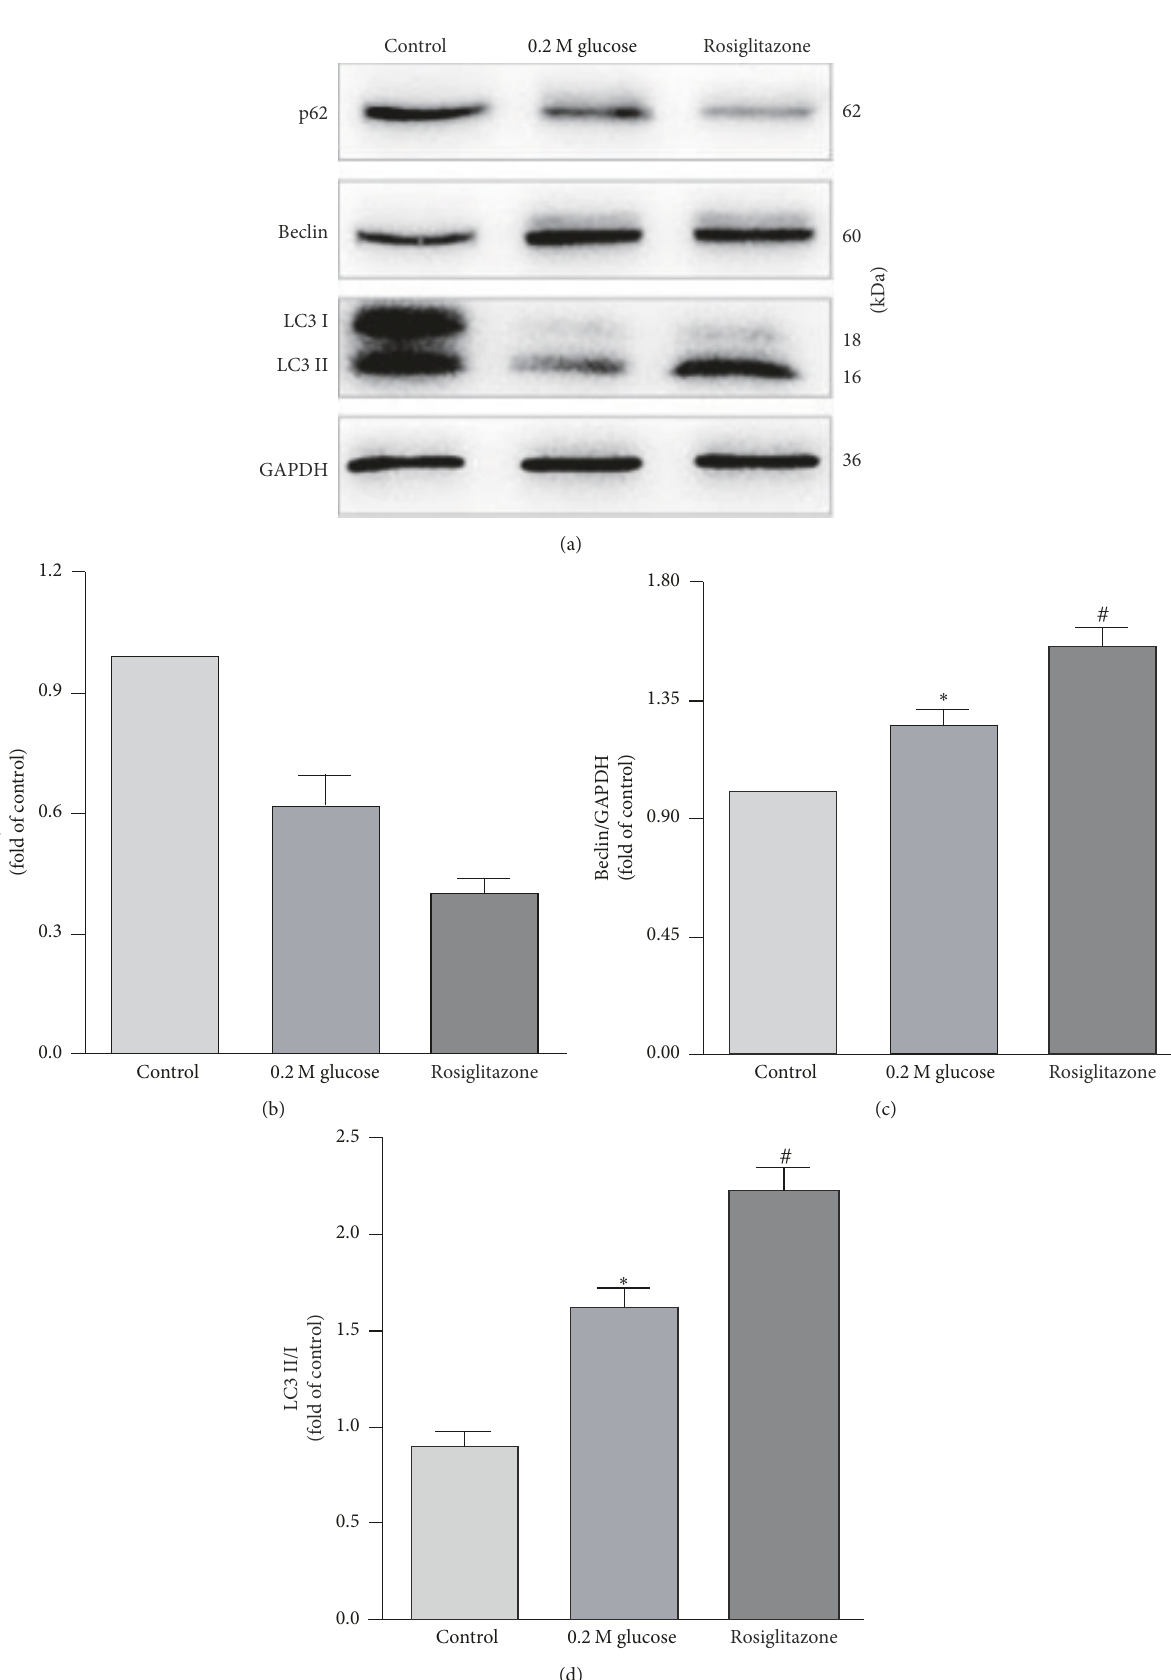
Figure 4: Western blot analysis showed an increased expression of Beclin-1 and LC3-II and a decreased expression of p62 in the NP cells treated with PPAR 𝛾 agonist. # represents a significant difference from 0.2 M high glucose condition (𝑝 < .05)